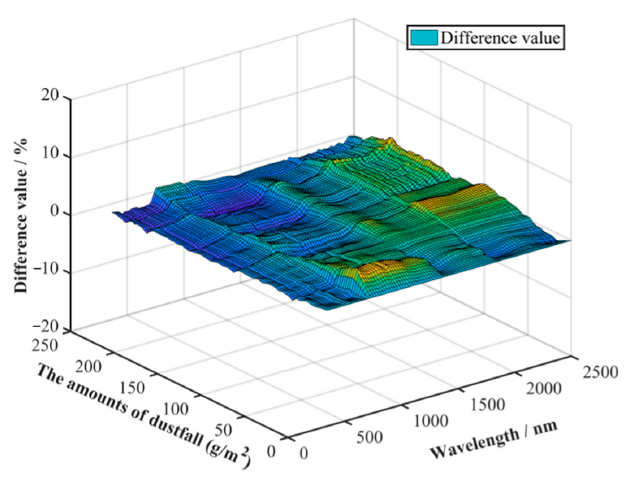
Figure 15. The variation of the difference between the corrected spectrum and the measured value as a function of wavelength and dust magnitude is calculated by Equation (30).